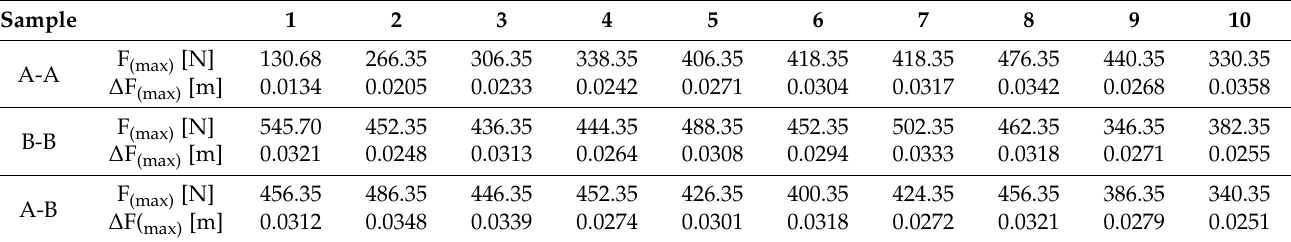
Table 4. Secret 10 fabric test results.